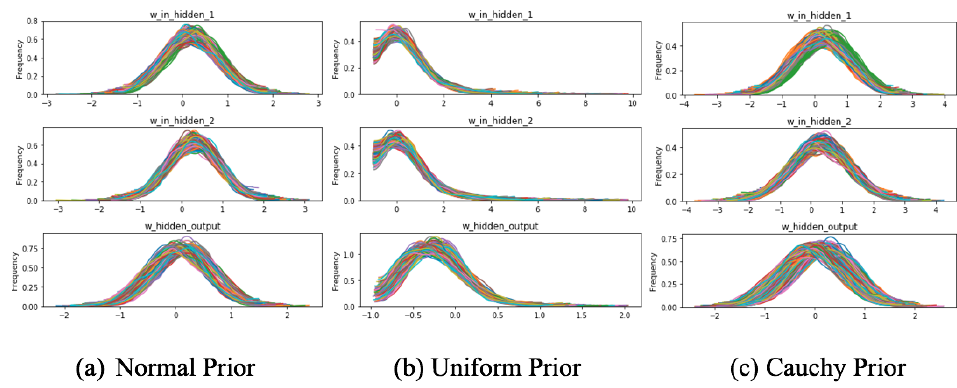
Figure 6. Different Priors on Posterior Weights Under Uncertainty Flow . Note here, the notation w i n h idden 1 means posterior weights in first hidden layer in our implemented BNN or BCNN.